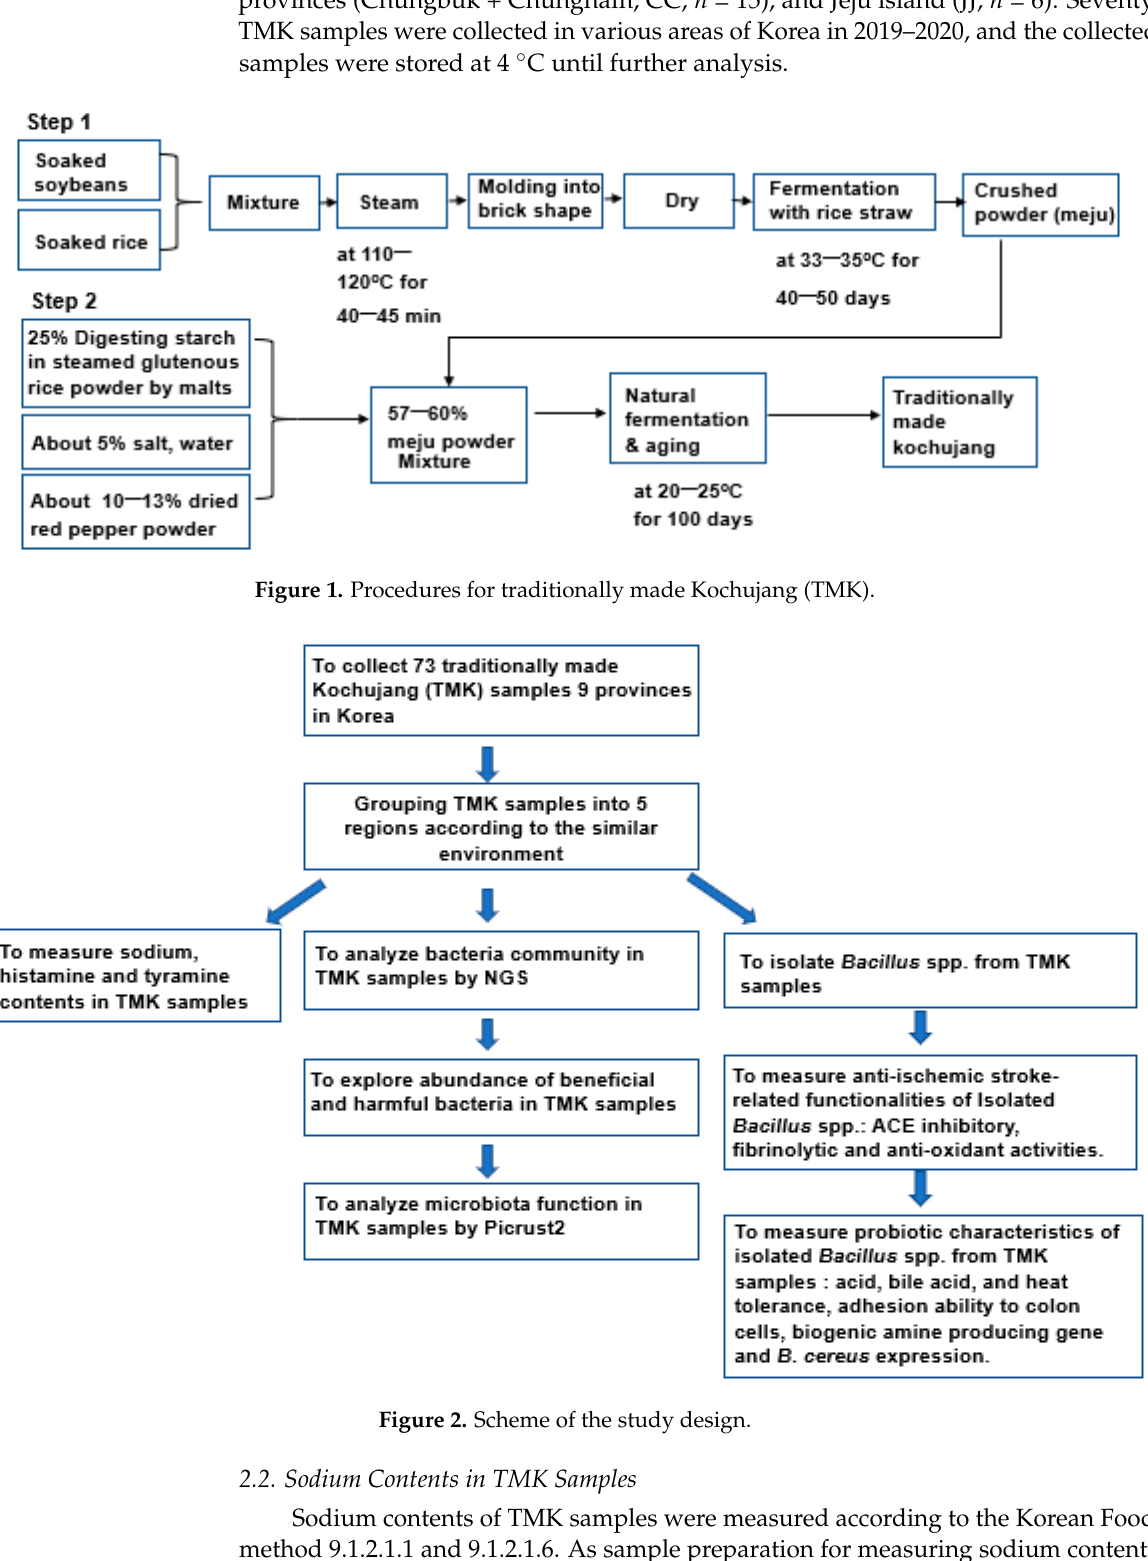
Figure 2. Scheme of the study design.